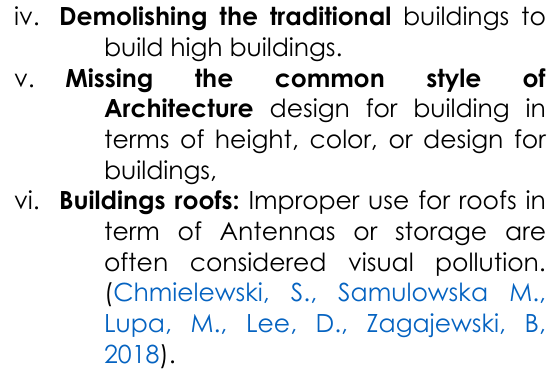
Figure 20: Deteriorating traditional building condition (air conditions are haphazard disrupted). f.